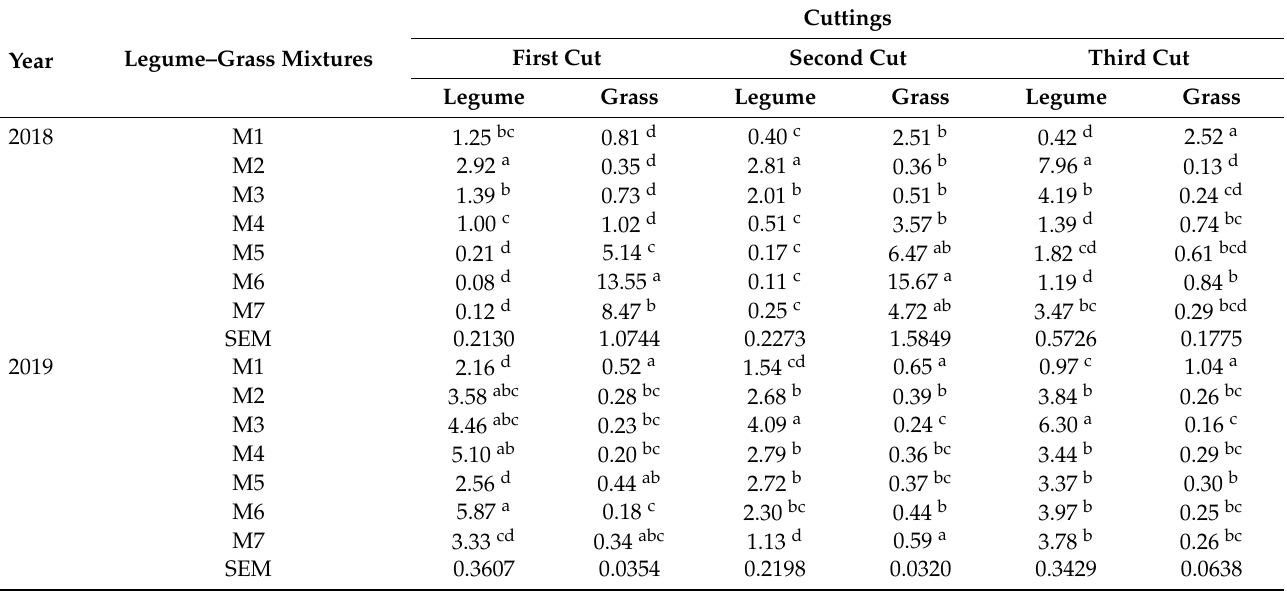
Table 6. Competition rate of legumes and grasses of different legume–grass mixtures at different cuttings for the establishment years of 2018 and